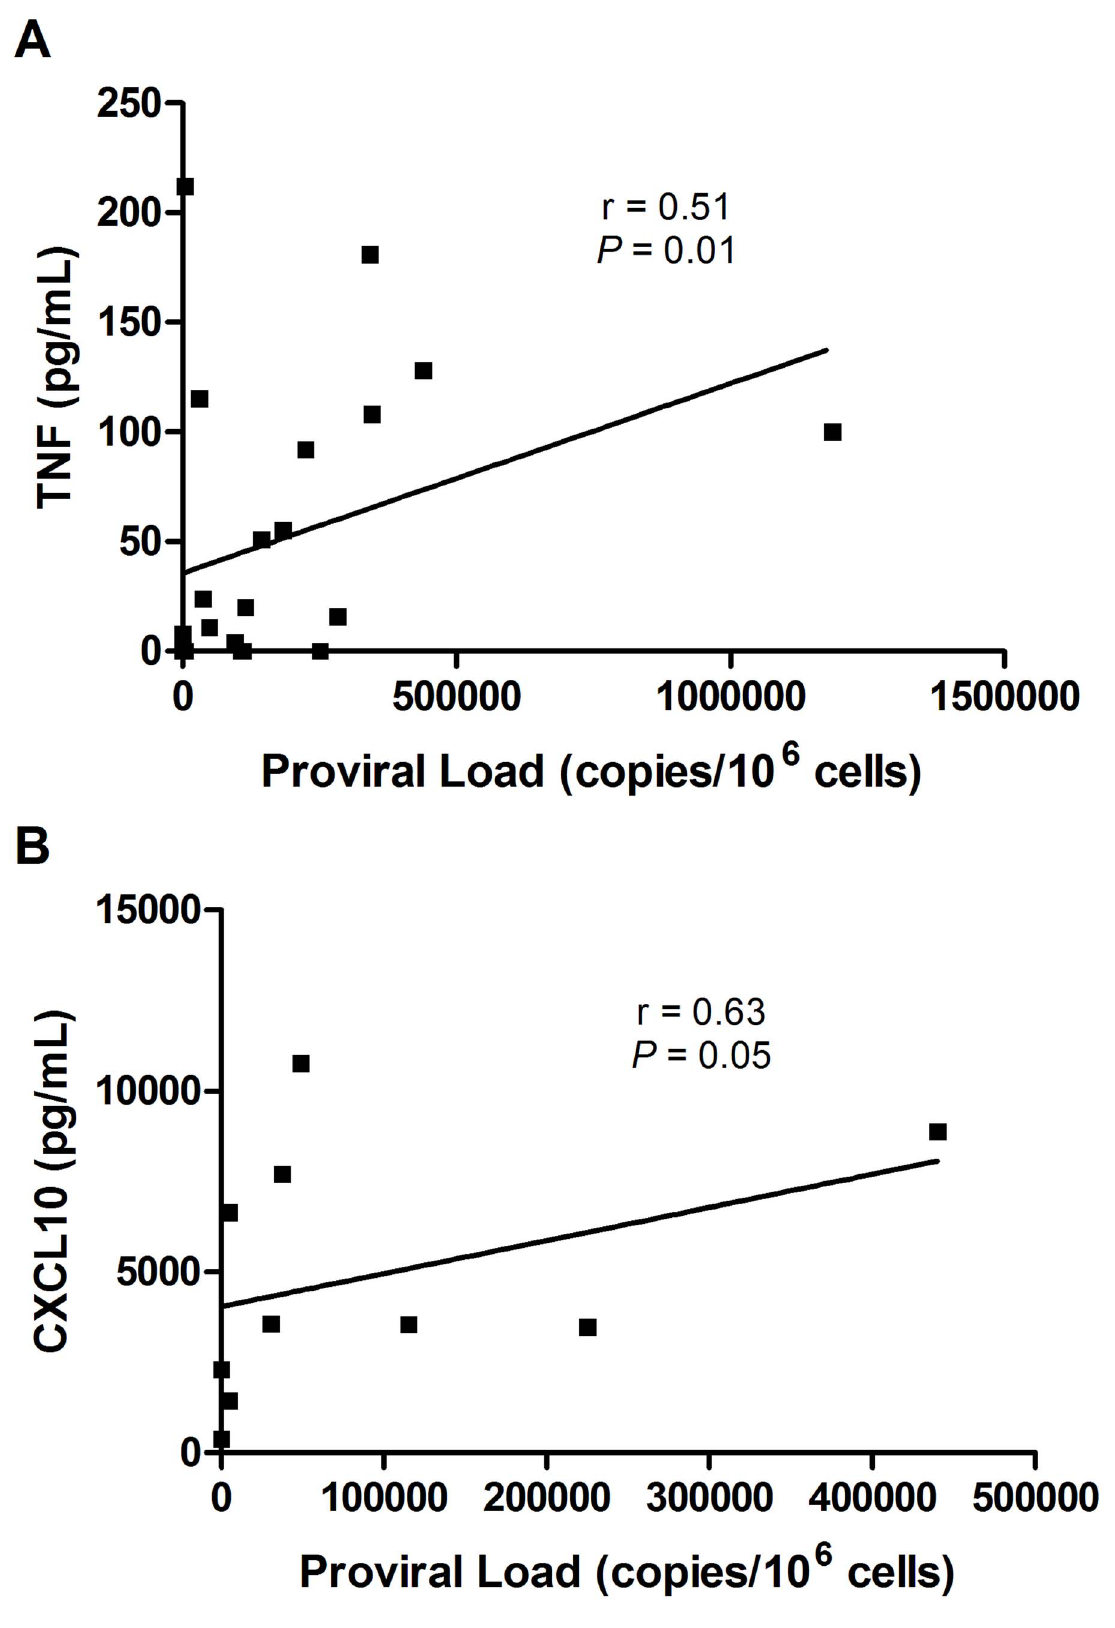
Fig. 7. Correlation between proviral load TNF and CXCL10 produced by macrophages from HTLV-1 infected subjects. Correlation between proviral load of HTLV-1 infected subjects and (A) TNF (n=22) and (B) CXCL10 (n=10) produced by macrophages. Spearman correlation and r significance test were used for statistical analyses ( P , 0.05). doi:10.1371/journal.pntd.0003399.g007 PLOS Neglected Tropical Diseases |